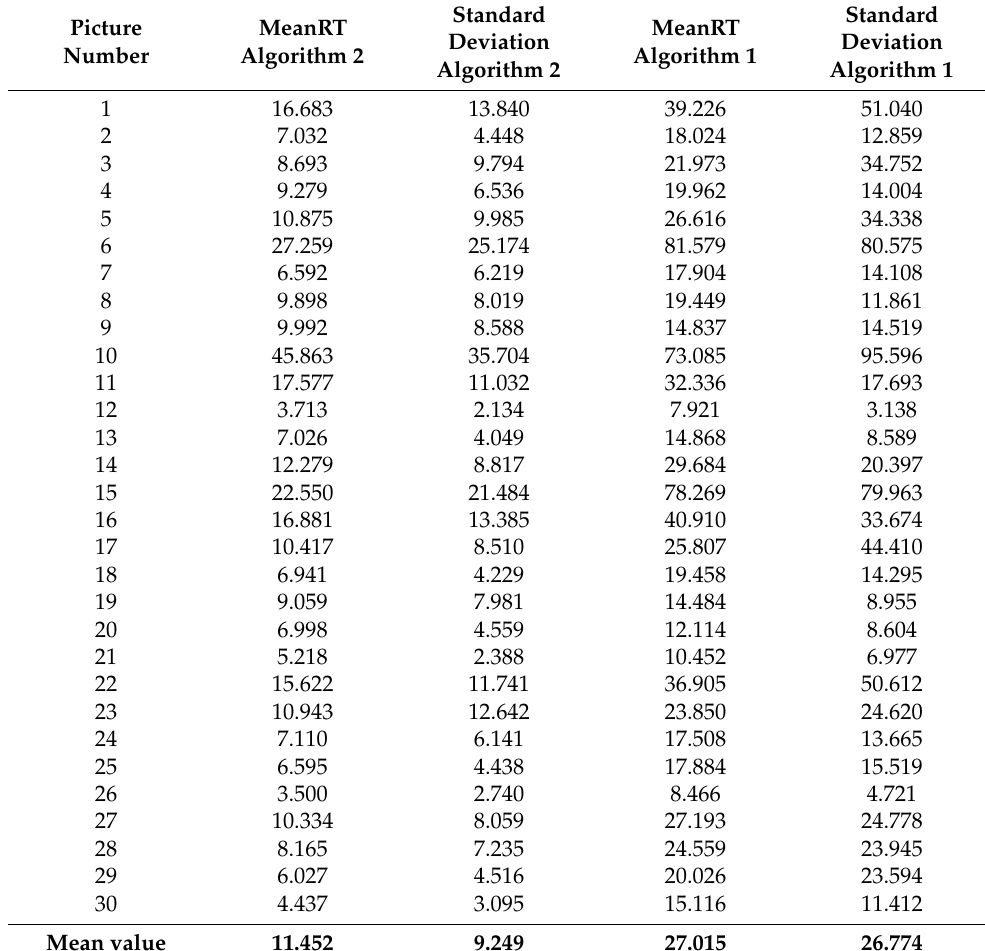
( b ) Figure 7. Images registered by RS-GD: ( a ) subject 10; ( b ) subject 7. The accuracy results of all tested methods are reported in Tables 2–4. The mean and standard deviation values of RSNR correspond to Algorithm 2 and RSNR values recorded for PAT and RS-GD are provided in Table 2. In addition, Table 2 show the success ratios of Algorithm 2 and whether classical methods managed to correctly align the tested pairs of images. Note that, in the case of severely perturbed sensed images, both classical meth- ods may misregister the inputs. The resulted accuracy rate of PAT is only 26.7%, while for RS-GD, it is 53.3%. Algorithm 2 had a 100% accuracy, correctly registering all tested im- ages in all runs. Table 2. RSNR values and success rates – Algorithm 2, PAT and RS-GD. Picture Number